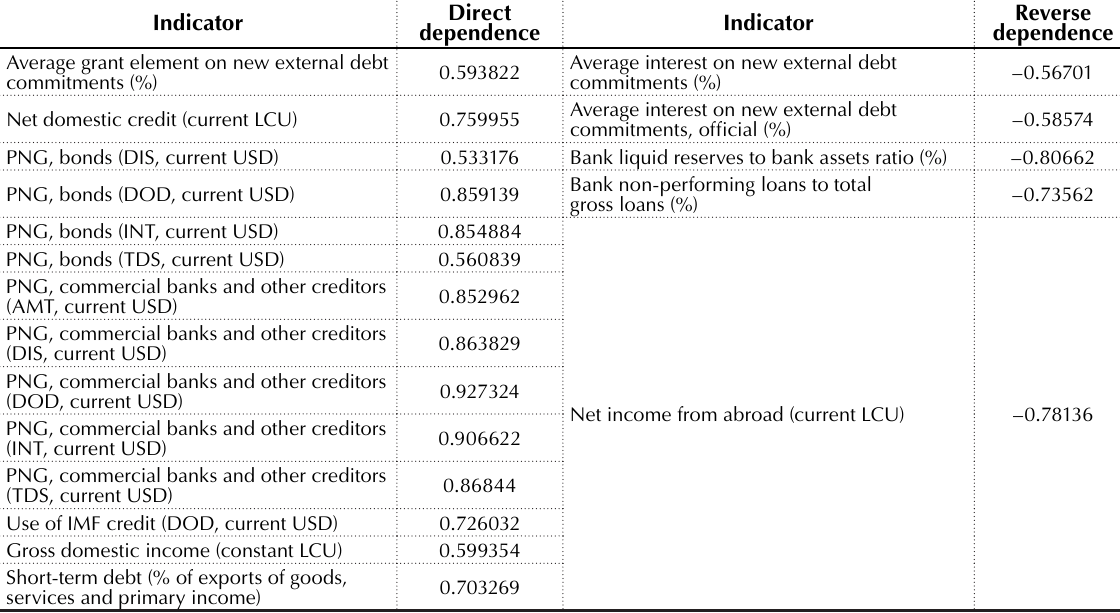
Table 5. Correlation coefficients of domestic loans to the private sector by banks (% of GDP) with researched